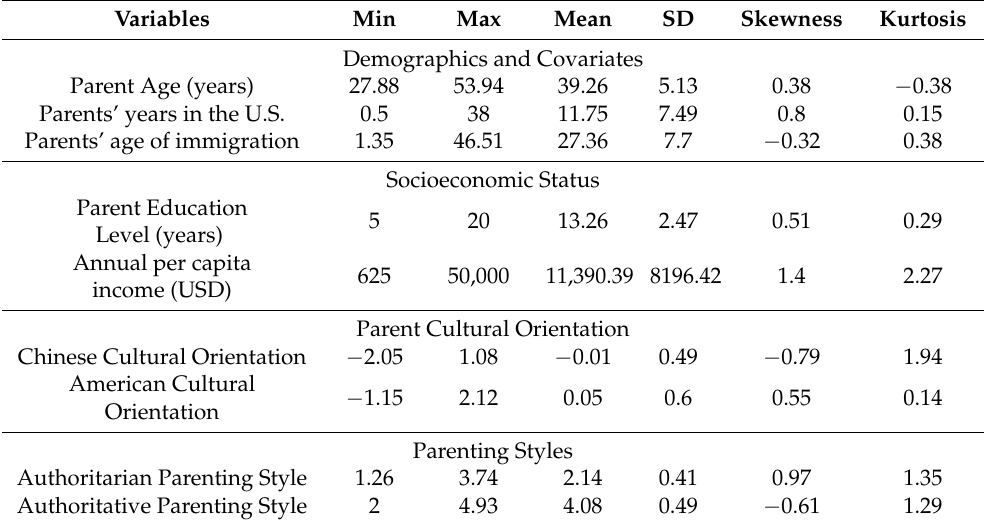
Table 1. Descriptive Statistics of Study